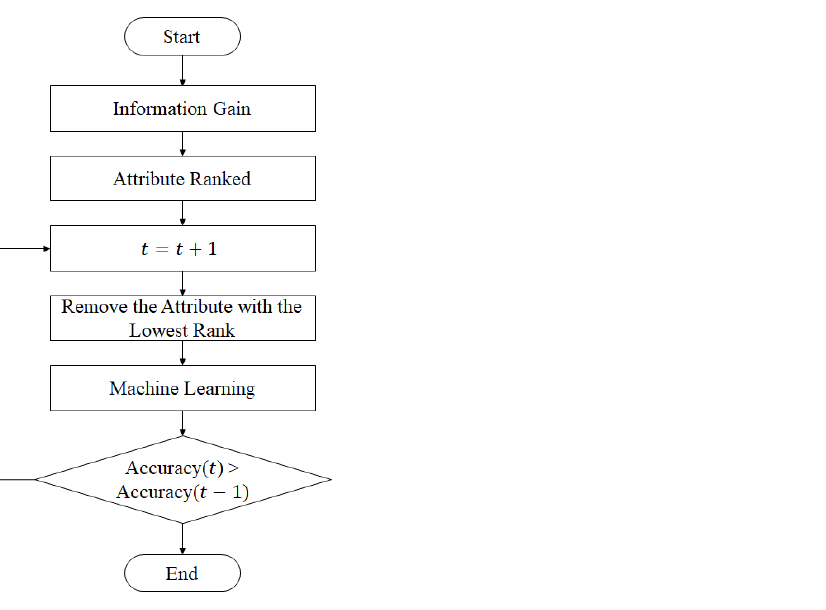
Figure 6. Feature selection algorithm with information gain.